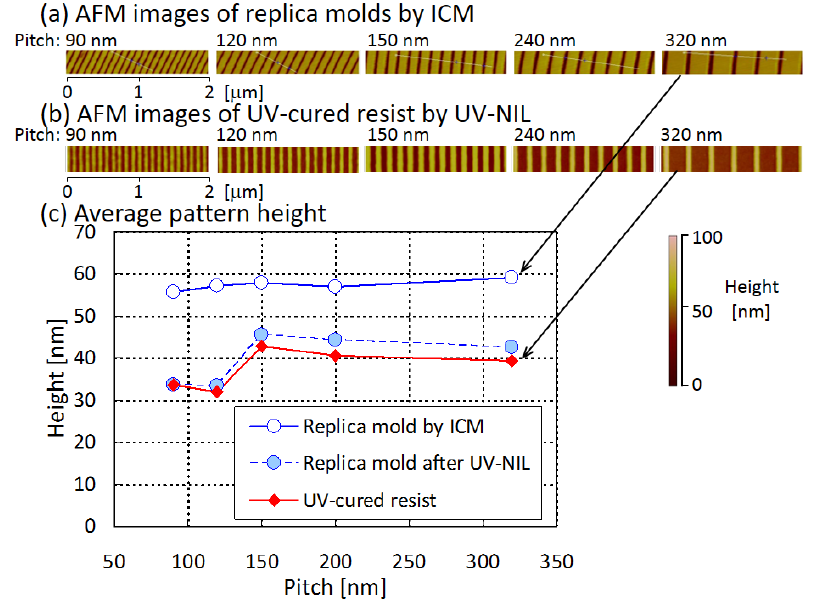
Figure 4. Pattern heights of injection-compression-molded replica (sample COP-1), after use in UV-NIL, and UV-cured resist, obtained by AFM analyses as a function of pattern pitch.